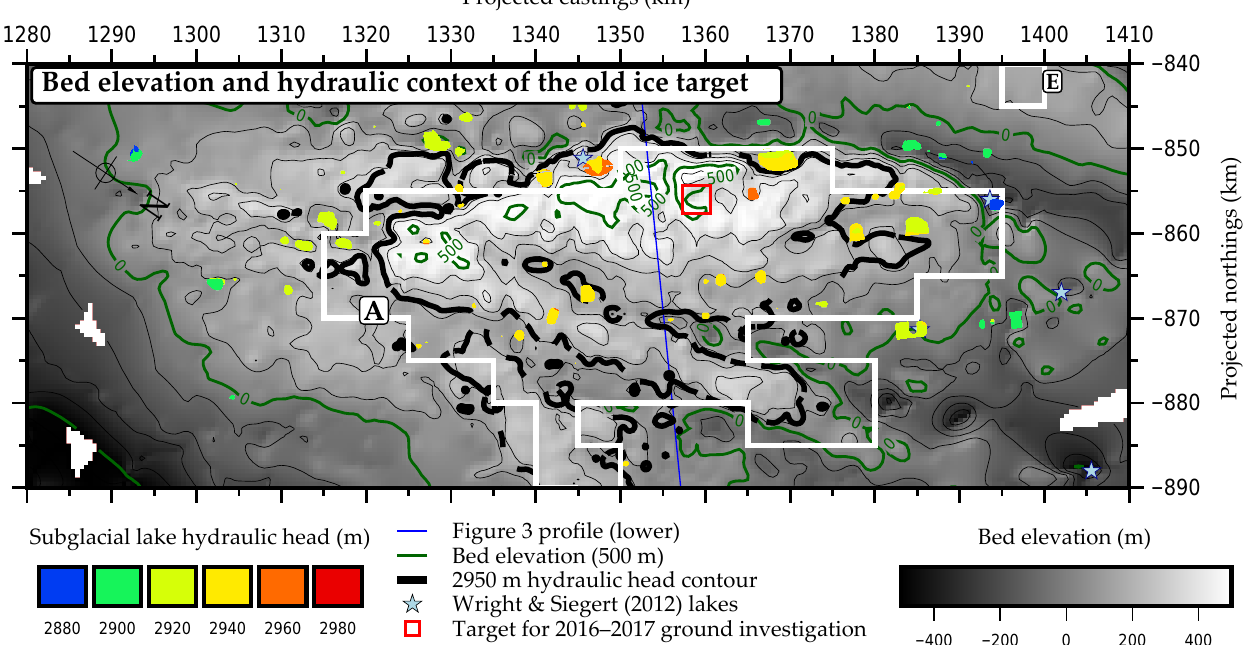
Figure 3 profile (lower) Bed elevation (500 m) 2950 m hydraulic head contour Wright & Siegert (2012) lakes Target for 2016–2017 ground investigation Figure 6. The selected target within Candidate A. Compilation bed elevation with imaged subglacial lakes superposed. Target region for further ground work lies near the highest point on the bed, northeast of the ice